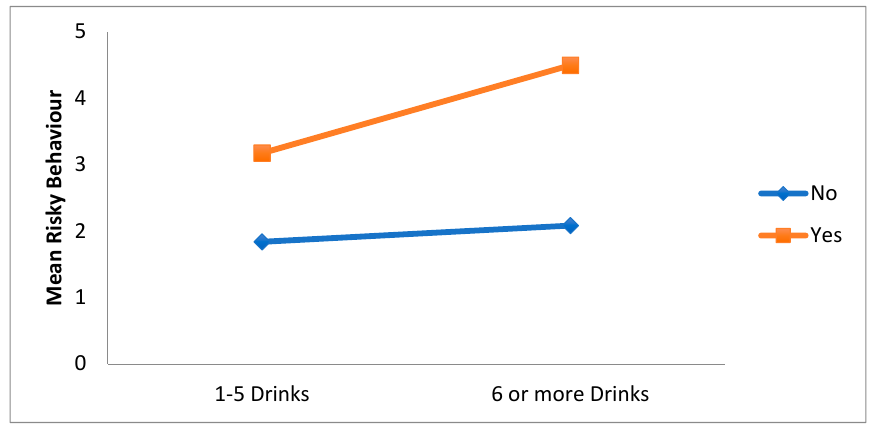
Figure 4. Interaction effect of alcohol use (yes/no) on the relationship between intensity of energy drinks use (1–5/6 or more drinks) and overall risky behavior.